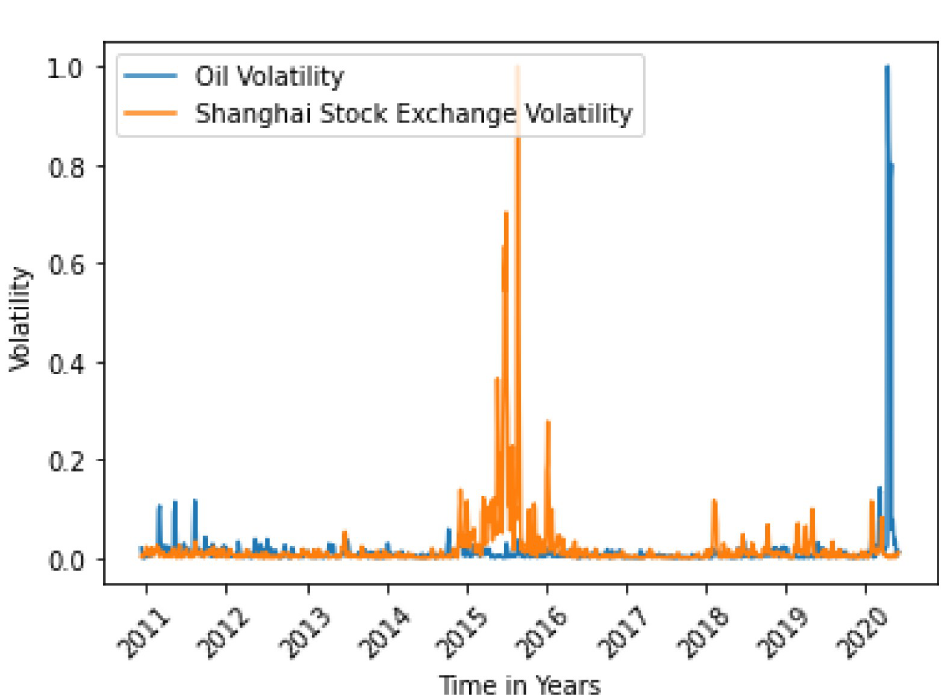
Fig 10. Shanghai Stock Exchange variance does not Granger cause oil variance. Here, the correlation between two data is -0.0019.